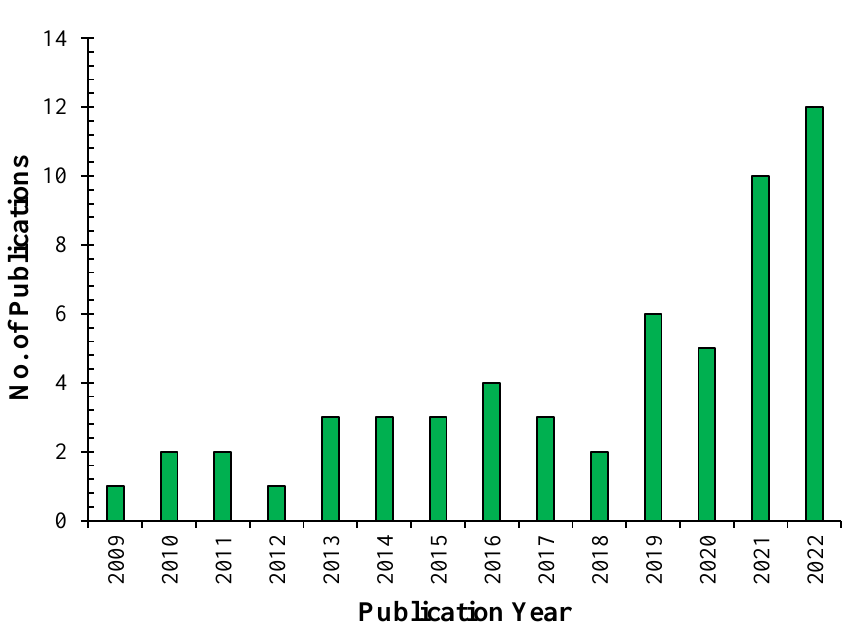
Figure 2. The number of publications using search string “TiO 2 nanotube and photocatalytic CO 2 reduction”, (Scopus database search on 5 September 2022).